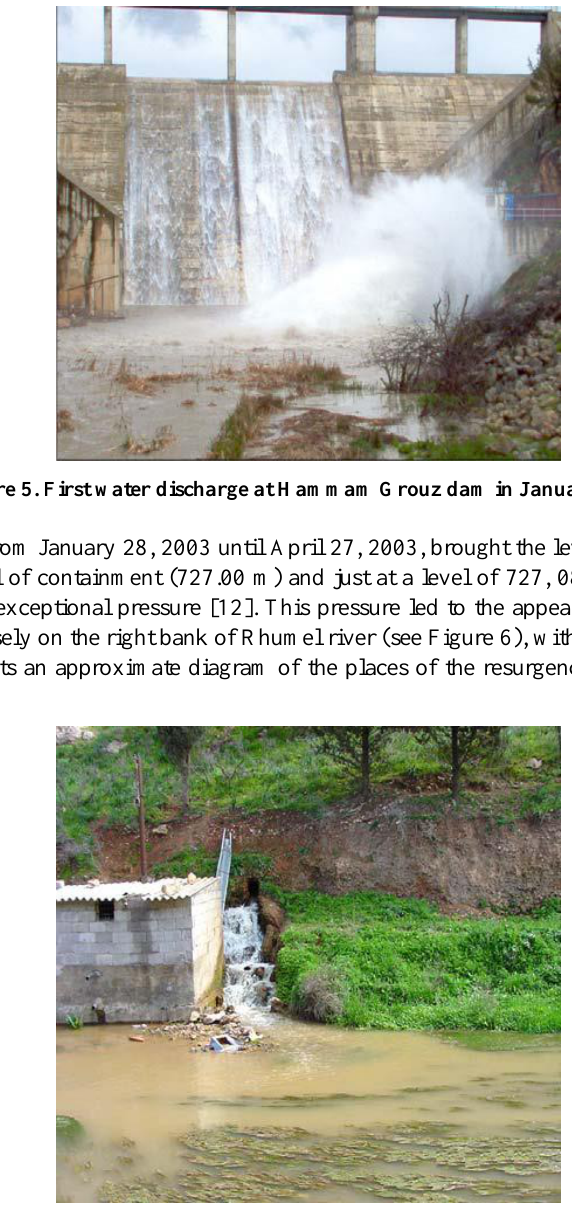
Figure 6. Appearance of resurgences downstream of the right bank of Hammam Grouz dam